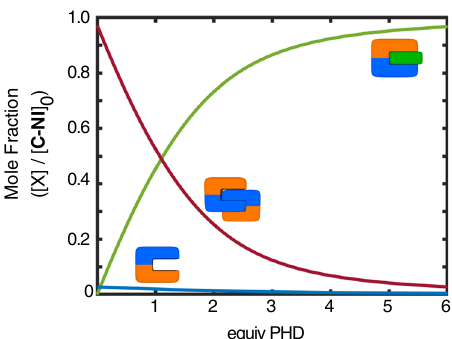
Fig. 10 Molecular reshuf fl ing. Speciation plot showing changes in the mole fractions of individual species originating from the π -clip (unbound C-NI , blue line; dimeric [ C-NI ] 2 , red line; host – guest complex C-NI ⊃ PHD , green line) with the supply of the guest PHD. [ C-NI ] 0 = 5.0 mM; see Fig. 8 for the K K dim and HG values used in the numerical simulation. PHD 1,10-